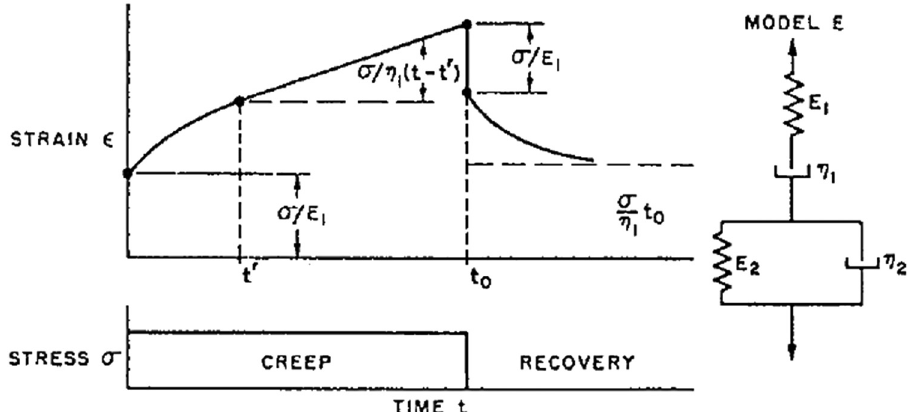
Figure 5: Maxwell approach ( spring and dashpot in series )